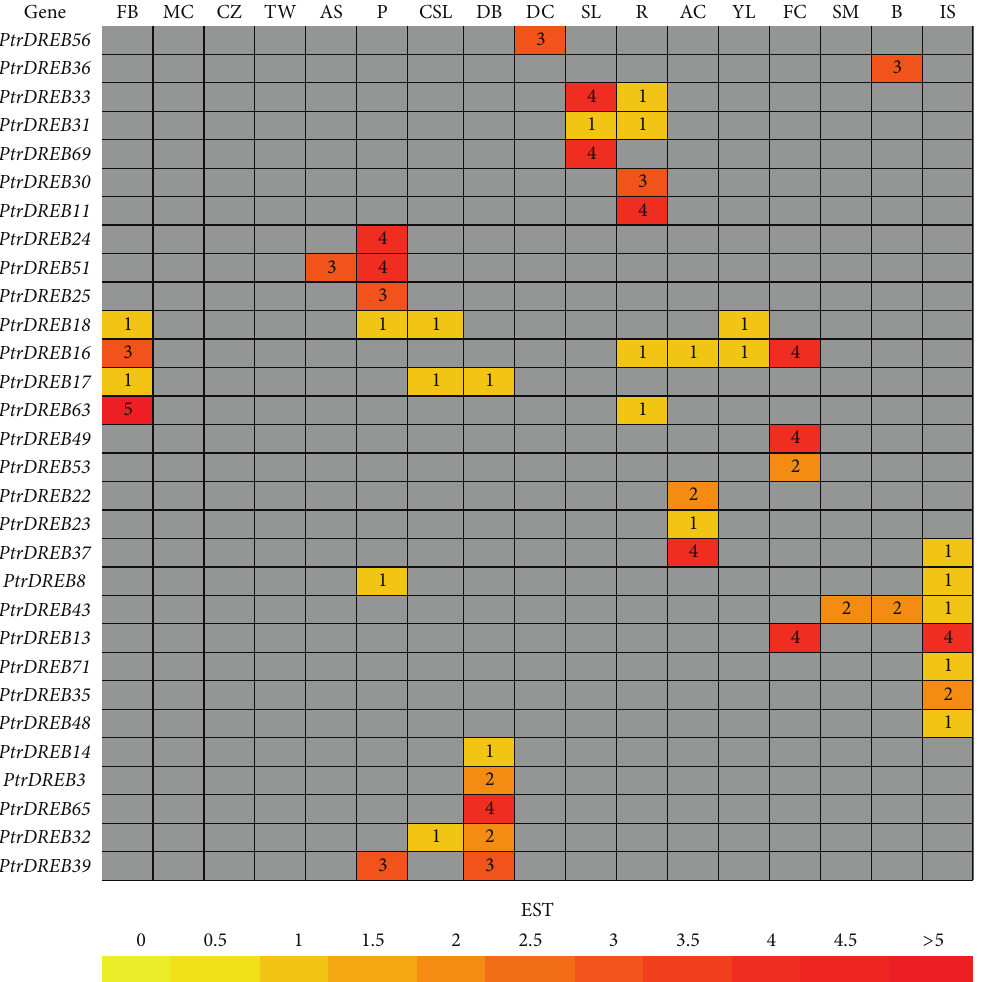
Figure 5: In silico EST analysis of Populus DREB genes. Color bar at bottom represents the frequencies of EST counts. FB: flower buds, MC: male catkins, CZ: cambial zone, TW: tension wood, AS: apical shoot, R: roots, CSL: cold stressed leaves, DB: dormant buds, DC: dormant cambium,SL:senescingleaves,P:petioles,AC:activecambium,YL:youngleaves,FC:femalecatkins,SM:shootmeristem,B:bark,IS:imbibed seeds. Gene names are shown on the